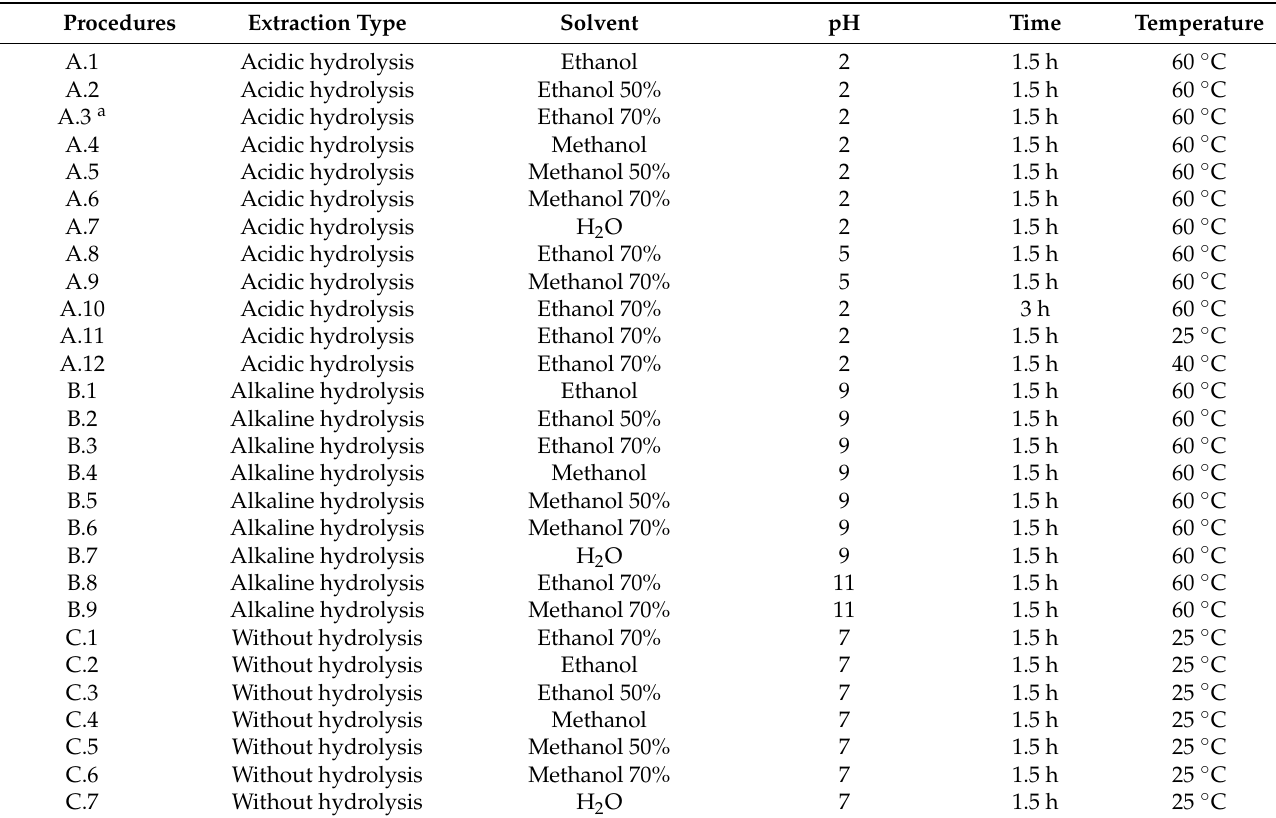
Table 1. Different extraction procedures evaluated for extraction of the 6 analyzed flavonoids in green